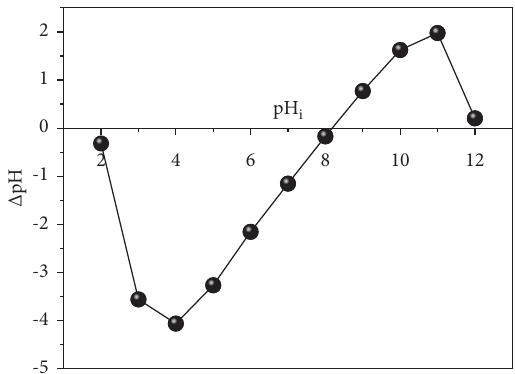
Figure 3: XRD patterns of RM and RMGC (inset is that of EEG).